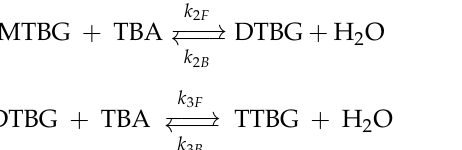
Table 3. Mass balances of the reactants and products. Component